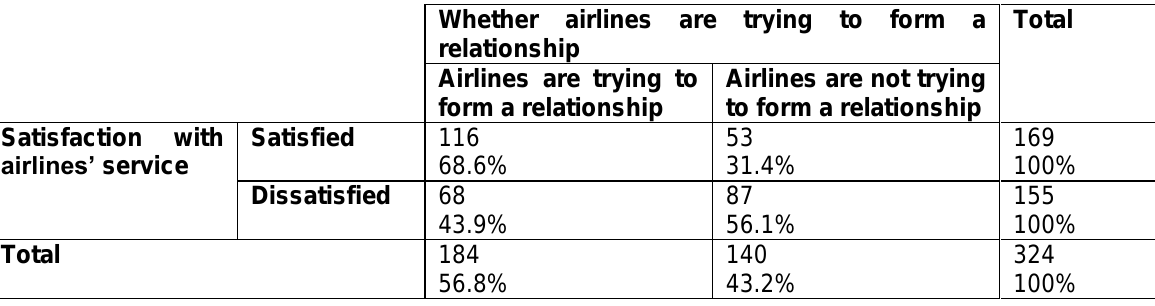
Table 1: A cross-tabulation between whether airlines are trying to form relationships with respondents and respondents’ satisfaction with the airlines’ service Whether airlines are trying to form relationship Airlines are trying to form a relationship